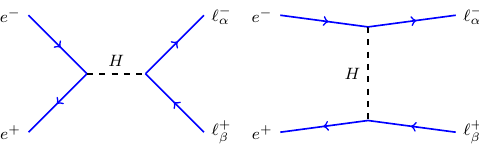
Figure 4. Feynman diagrams for off-shell production of H at future lepton colliders (cf. the process in Equation (3)). Figure from Ref. [20].